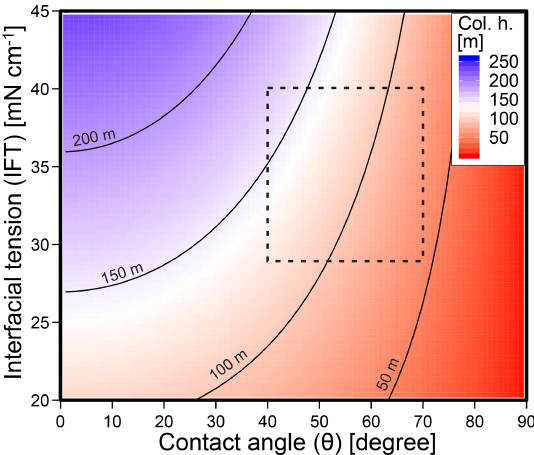
Figure 4. Figure showing the influence of contact angle ( θ ) and in- terfacial tension (IFT) on supported CO 2 column height. Black lines are contours at 50m intervals. The full range of IFT and θ shown here has been reported for CO 2 –brine–rock systems; the dashed rectangle indicates conditions likely for geological storage. Column height calculated using Eqs. (1) and (2) with a pore-throat diame- ter of 100nm, a typical value for organic-poor shales (Dong et al., 2017), and a CO 2 density of 630kgm − 3 , correlating to a depth of about